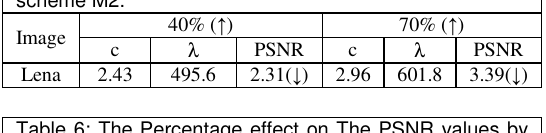
Table 5: The Percentage effect on the PSNR values by the Percentage increase in parameters used in the proposed scheme M2.